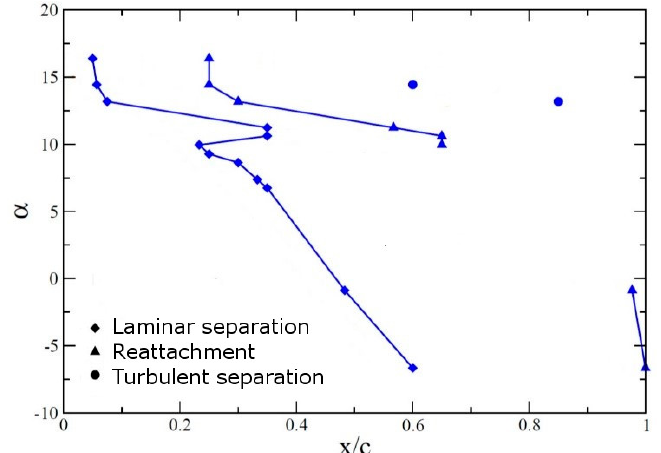
Figure 16. Separation and reattachment locations as function of angle of attack (AoA). (Reprinted from [28]).